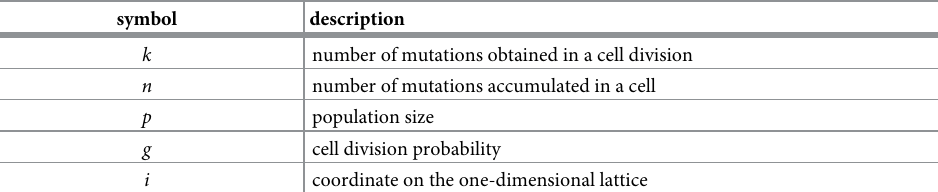
Table 1. Variables.